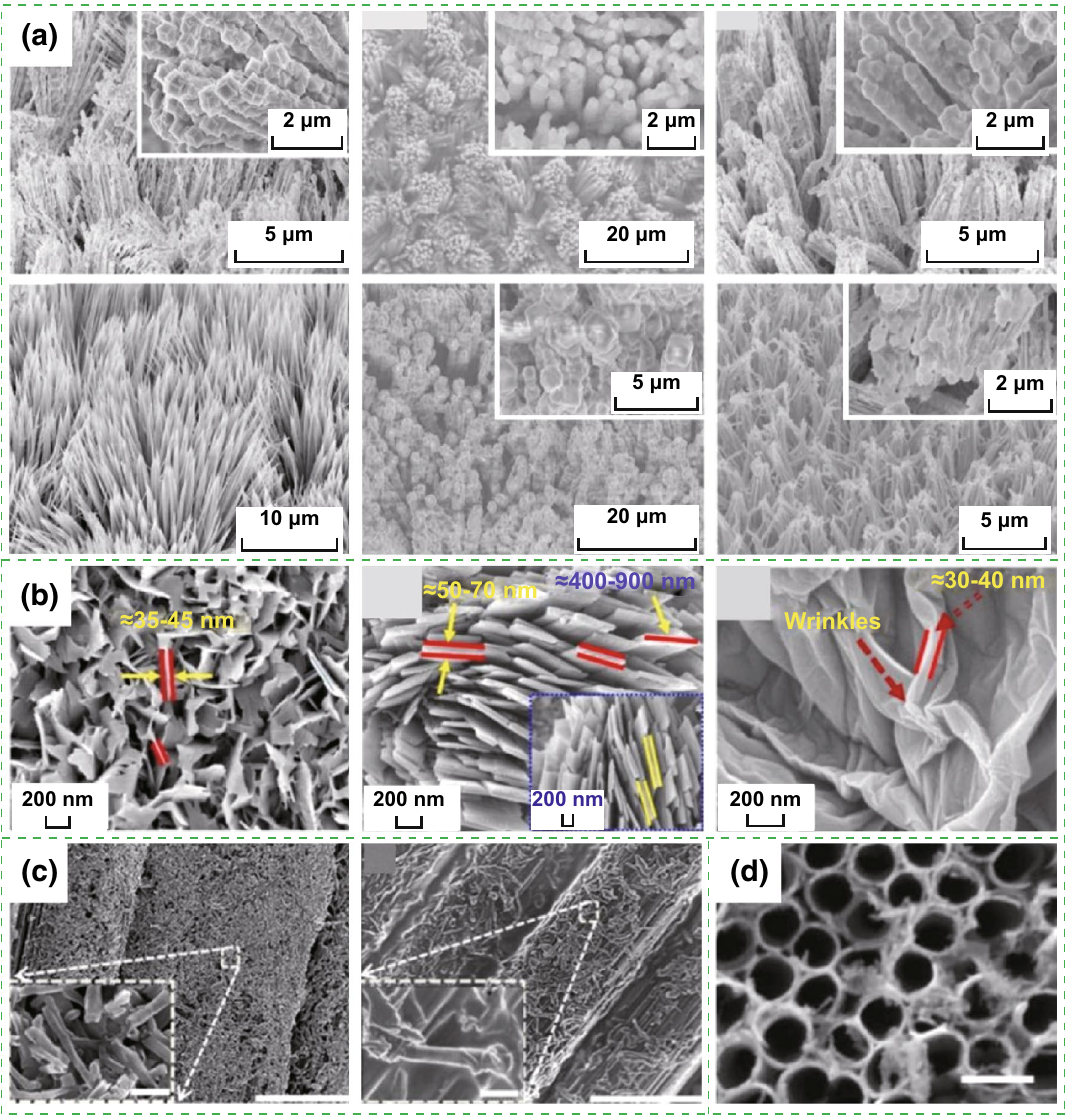
Fig. 3 a SEM images of ZnCo 2 O 4 @Zn‑Co‑S HA, as‑prepared CNTFs@Zn/Co‑Zif, ZnCo 2 O 4 @ZnCo 2 O 4 HA, CNTFs@H–Co 3 O 4 NA, CNTFs@H–Co permission from Ref. [21]. c SEM images of a CNF‑coated yarn and a PEDOT: PSS/CNF‑coated yarn (scale bar, 10 μm). Reprinted with per‑ mission from Ref. [22]. d SEM images of the TiO 2 nanotube arrays on the Ti wire (scale bar, 100 nm). Reprinted with permission from Ref.